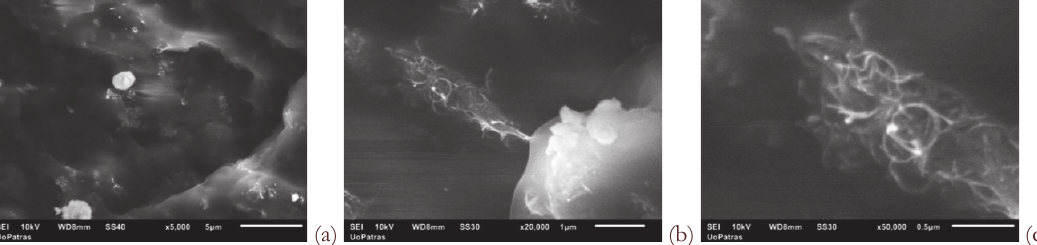
Figure 3: SEM photos of an area in the MWCNT/PP 2 wt%_04 specimen: a. x5,000, b. x20,000 and c. x50,000.